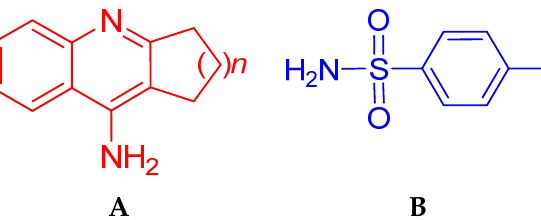
Figure 1. Structures of pharmacophores: ( A ) 4-amino-2,3-polymethylene-quinolines; ( B ) p -tolylsulfonamide.